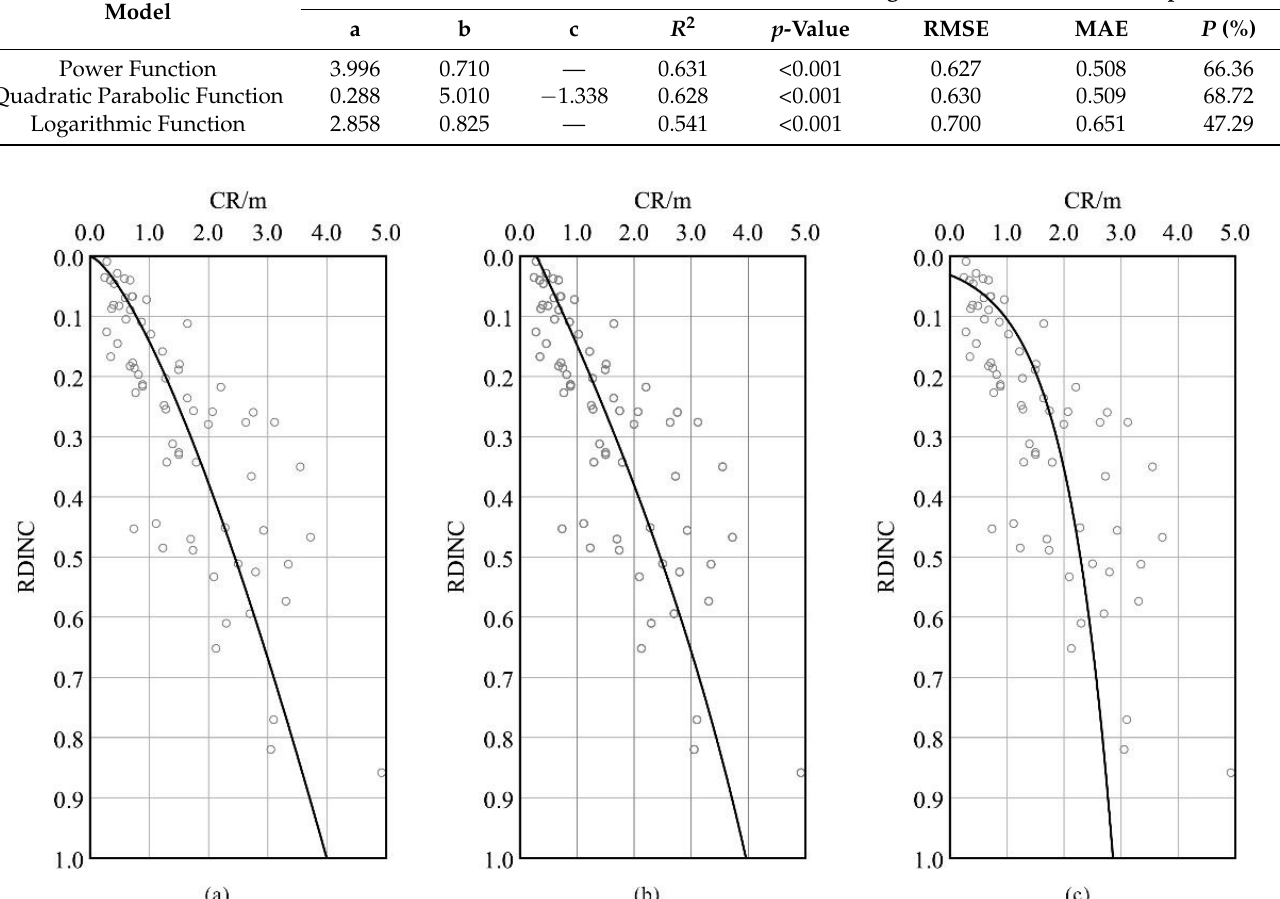
Figure 4. The HDM of canopy biomass. SBD is the standardized biomass density; and RCR is the relative crown radius. 3.2. Comparison of AGB Distributions Simulated by Different Distribution Models 3.2.1. Visual Comparison The AGB distribution of the plot simulated by the two biomass distribution models is shown in Figure 5. The visual comparison revealed that the AGB distribution within the HDM-based simulations was more homogeneous than that of the LDM, with a larger dis- tribution area, continuous distribution, and less variation in biomass within adjacent ranges. However, the AGB distribution in the plot based on LDM simulation is more con- centrated. The distribution area is tiny (just some points), showing sporadic distribution,